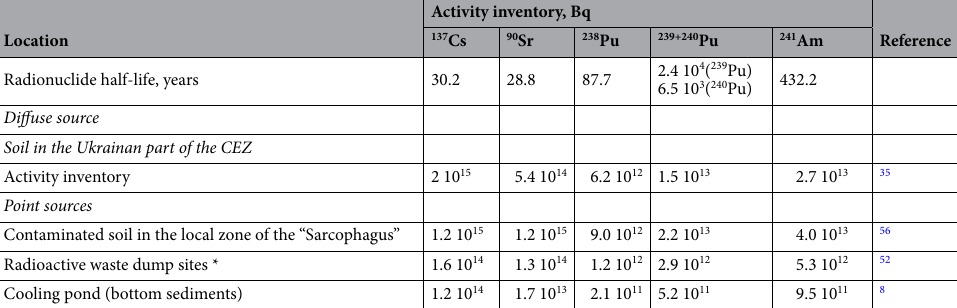
Table 1. Inventory of total activity of main radiologically important radionuclides ( 137 Cs, 90 Sr, 238-241 Pu, 241 Am) in various locations inside the CEZ (activity values decay-corrected to reference date 2015). *estimates for individual radionuclides derived from total activity assuming that activity of waste is dominated by the fuel